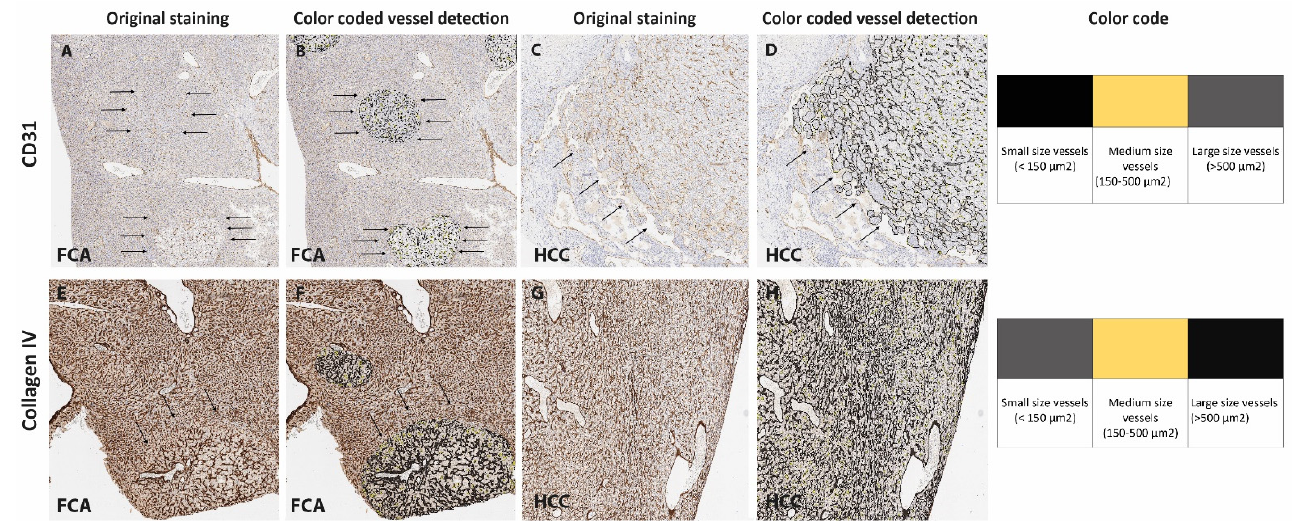
Figure 3. Computer-assisted subgrouping of vessels. CD31-based vessel subgrouping ( A – D ) for FCA ( A ) and CD31 ( B ) subgroups and HCC ( C ) and CD31 ( D ) subgroups. Collagen IV-based vessel subgrouping ( E – H ) for FI ( E ) and Collagen IV ( F ) subgroups and HCC ( G ) and Collagen IV ( H ) subgroups. Arrows mark the lesion in ( A – F ). Magnification 5 × . Color coding of subgroups: ( A , D ) black-colored areas highlight small-sized vessels (<150 µ m 2 ), yellow-colored areas highlight medium-sized vessels (150–500 µ m 2 ), and grey-colored areas highlight large-sized vessels (>500 µm²). ( F , H ) Grey-colored areas highlight small-sized vessels (<150 µ m 2 ), yellow-colored areas highlight medium-sized vessels (150–500 µ m 2 ), and black-colored areas highlight large-sized vessels (>500 µm 2 ).